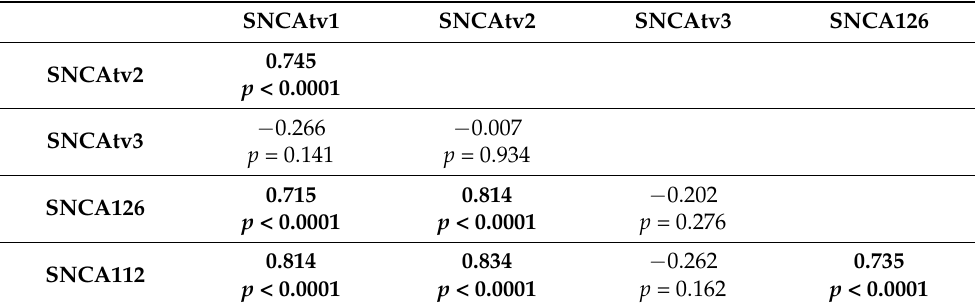
Table 4. Correlation SNCA transcript variant expression in LBD temporal cortices.